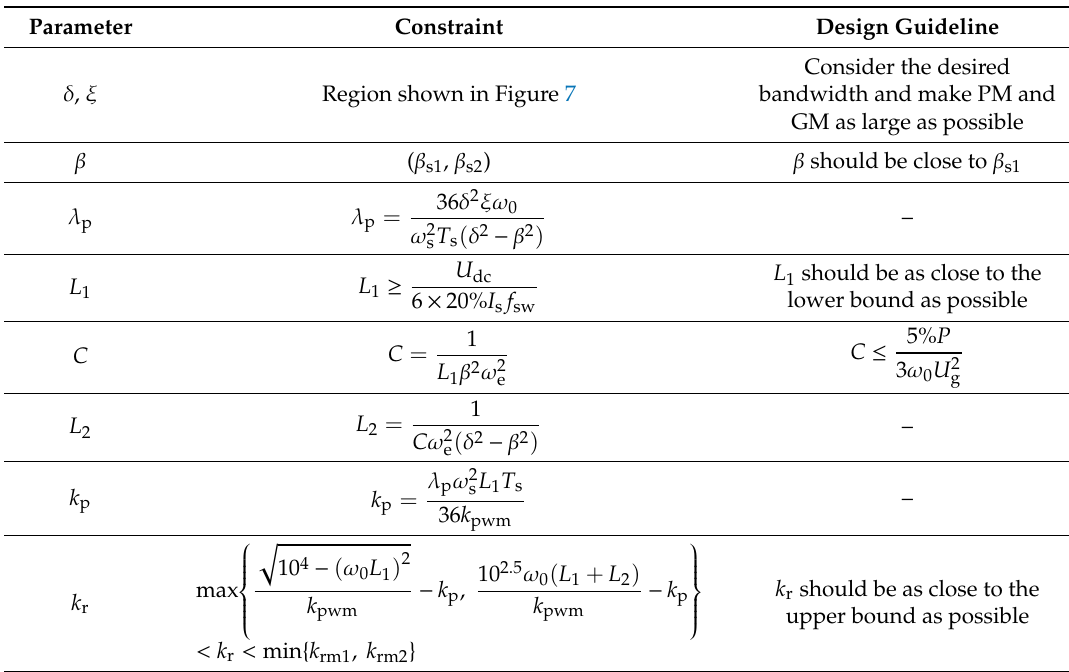
Table 1. Parameter Constraint and Design Guideline.